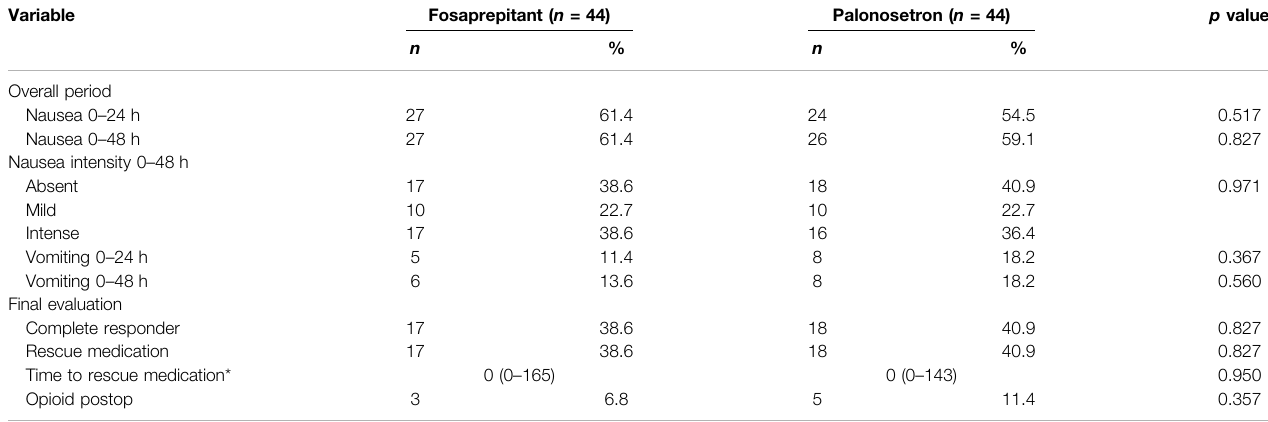
TABLE 3 | Final evaluation variables for the treatment groups. Variable